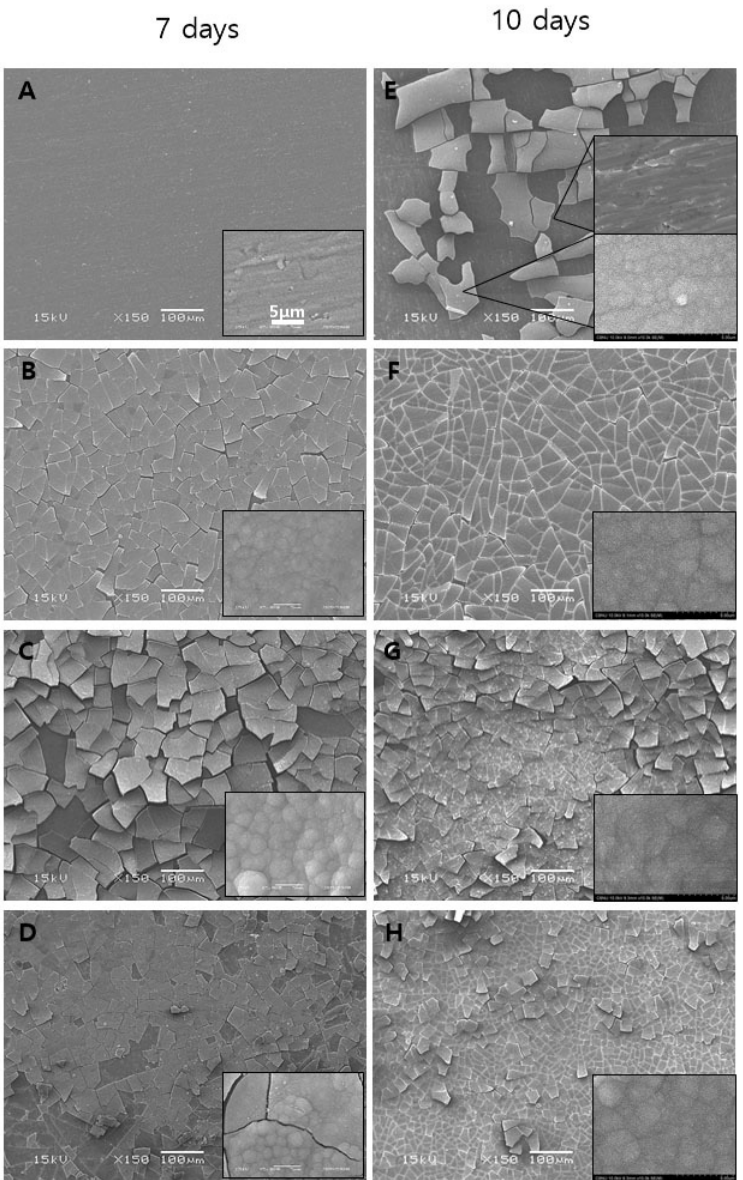
Figure 4. FE-SEM images of ( A , E ) PT, ( B , F ) PTN, ( C , G ) PTNA, and ( D , H ) PTNAC specimens surfaces after immersion in simulated body fluid (SBF) for ( A – D ) 7 and ( E – H ) 10